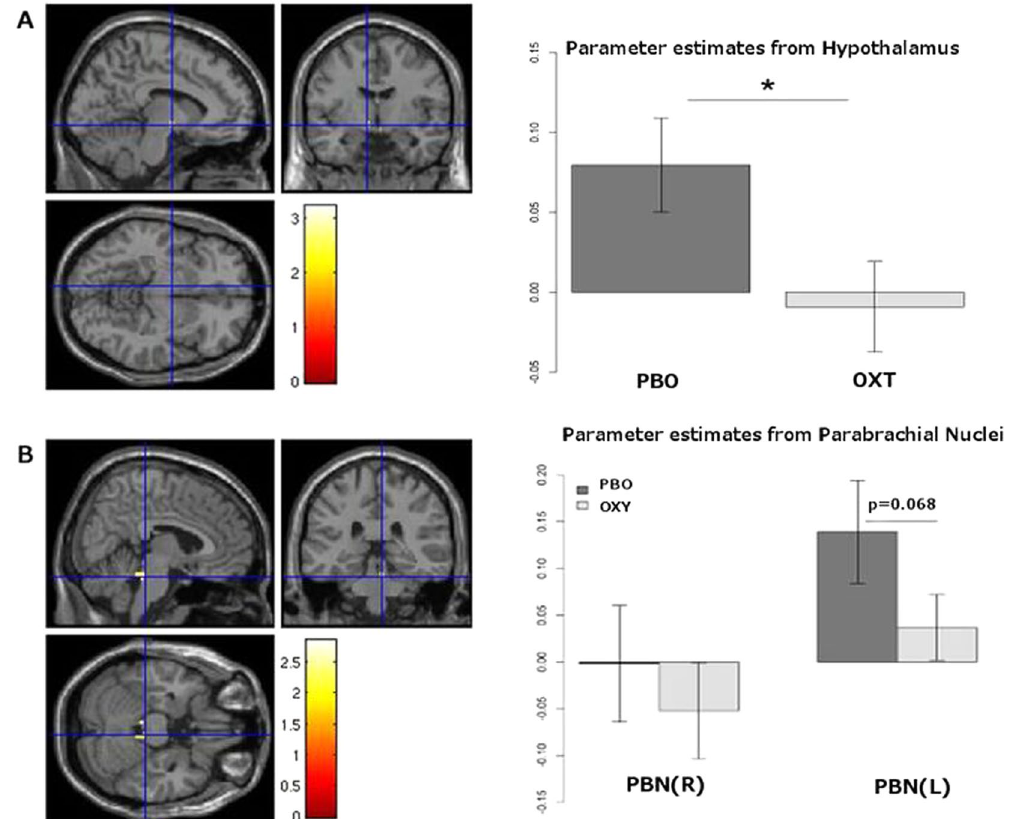
Figure 1. Hypothalamic and parabrachial nuclei (PBN) response to oxytocin. A: (A) Examination of the contrast of high calorie versus low calorie foods within the hypothalamus across all datasets (N = 48). The statistical parametric map is overlaid on the SPM8 T1 template image and thresholded at p < 0.05 uncorrected for display purposes. After small volume correction, one voxel − 8, − 6, − 8 survives at p = 0.0125. (B) Parameter estimates extracted from the hypothalamus ROIs showing a significant decrease in the parameter estimate in the oxytocin (OXT) condition compared to placebo (PBO). B: (A) Examination of the contrast of high calorie versus low calorie foods within the PBN across all datasets (N = 48). Image is thresholded at p < 0.05 uncorrected for display purposes. (B) Parameter estimates extracted from the PBN ROIs showing a trend towards decrease in the parameter estimate in the right PBN in the oxytocin condition (p =